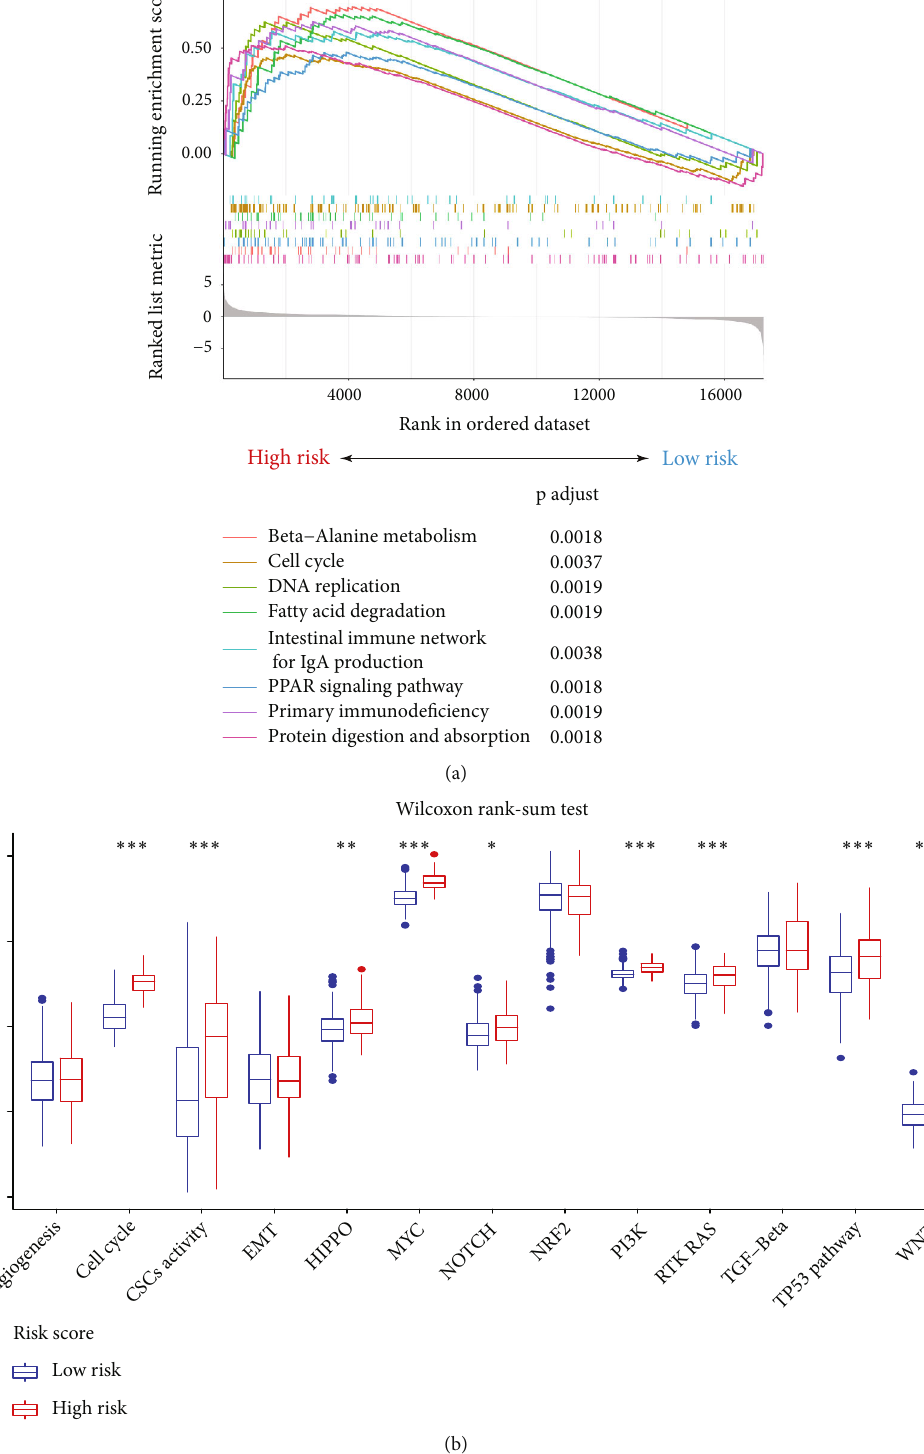
Figure 9: Functional and pathway analyses. (a) Enriched functions and pathways associated with RS. (b) Correlations between oncogenic pathways and the RS; Wilcoxon rank-sum test, ∗ P < 0 : 05 , ∗∗ P < 0 : 01 , and ∗∗∗ P < 0 : 001